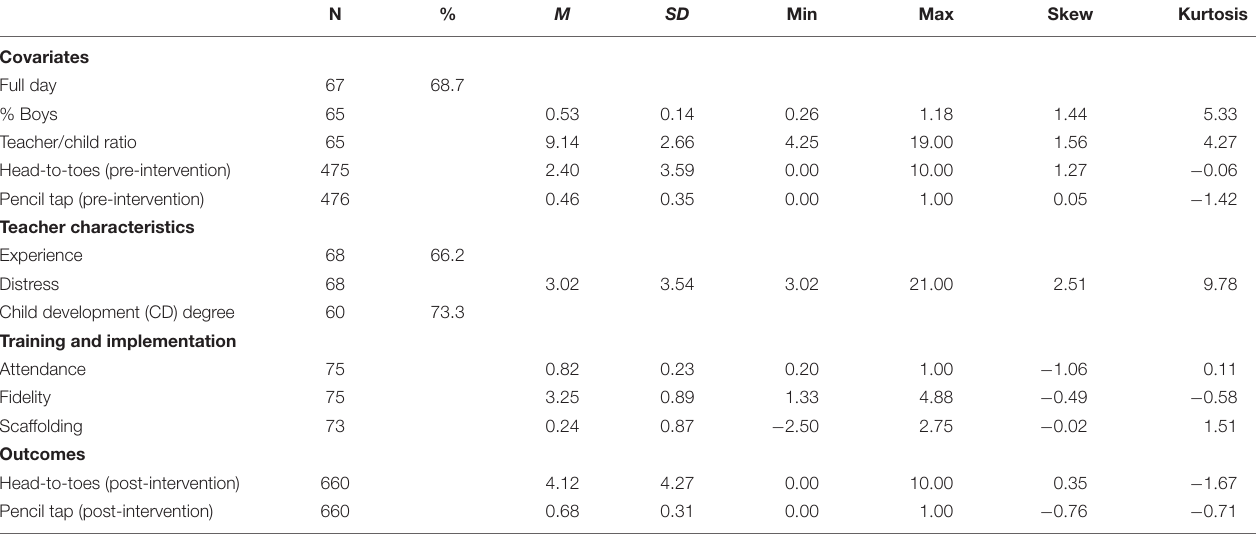
TABLE 1 | Descriptive statistics for classrooms and children.